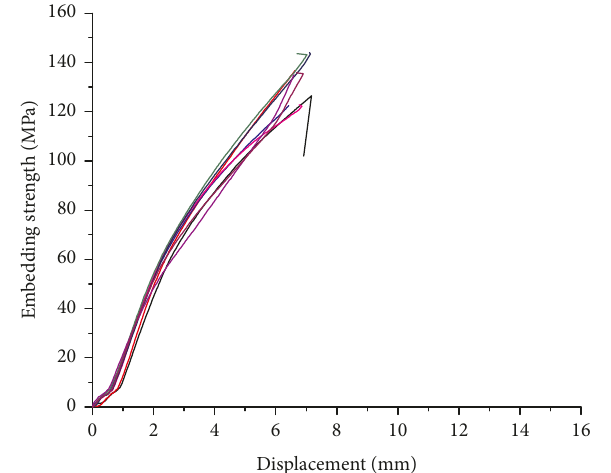
Figure 7: Strength-displacement curve of group H1.